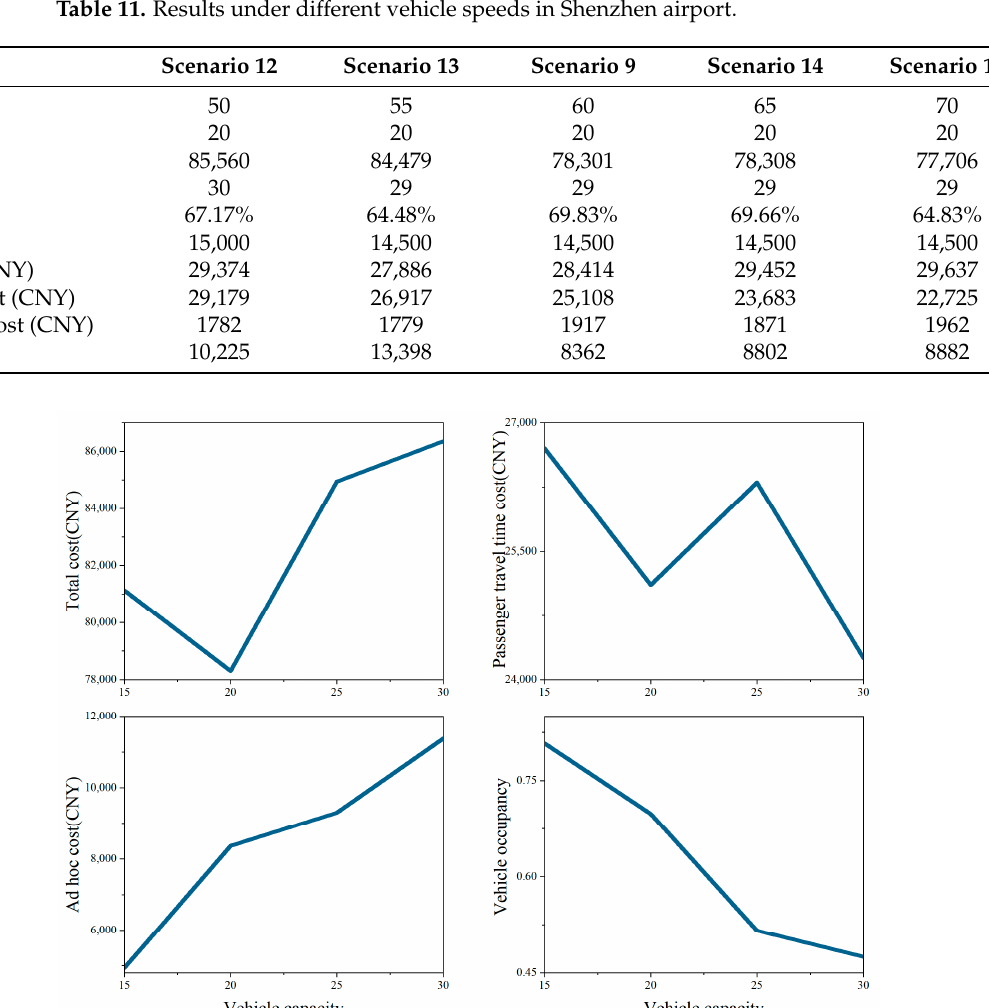
Figure 14. Sensitivity analysis of vehicle capacity in Shenzhen airport.